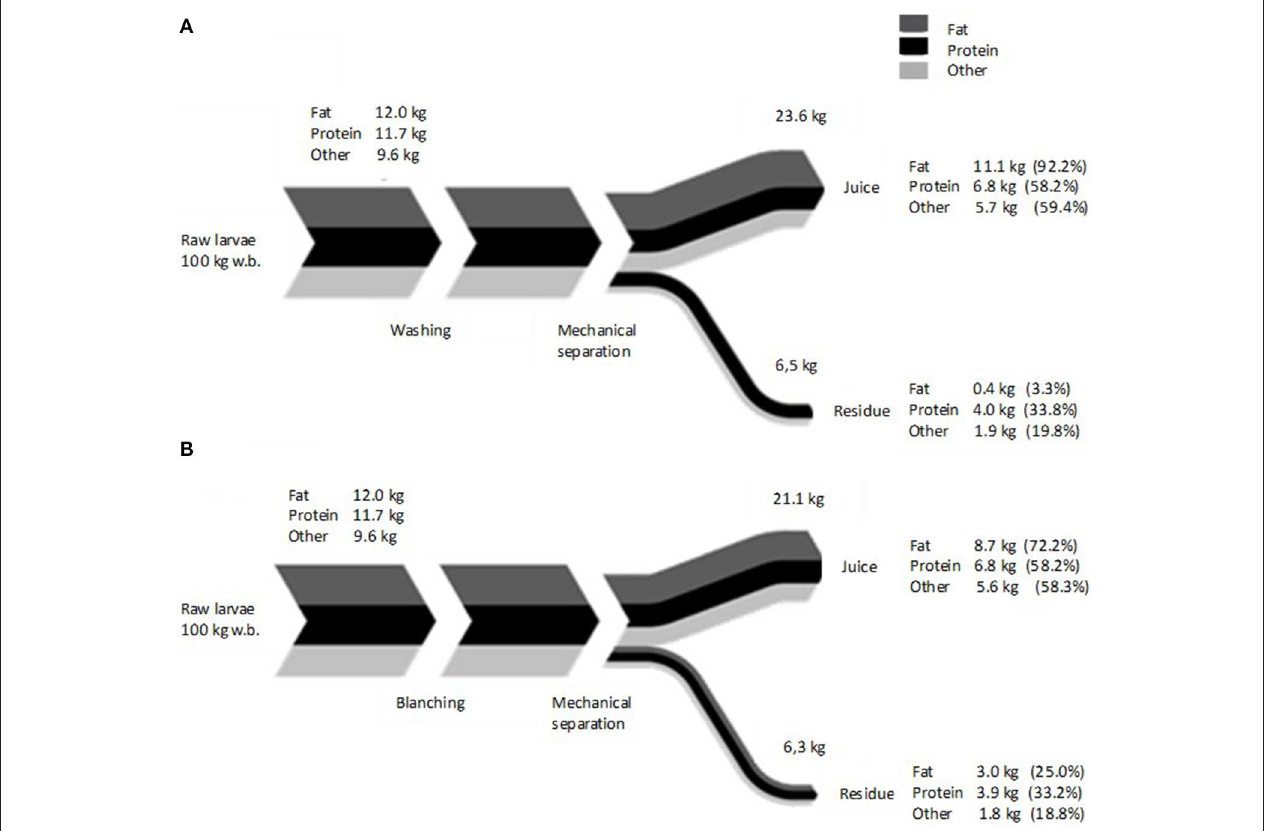
FIGURE 3 | Average mass balance of (A) washed, and (B) blanched larvae submitted to mechanical separation. Data are based on 100kg larval fresh basis, n = 3. Values in brackets represent the percentage of recovered component relative to the initial quantity in fresh insects. Line thickness represents the value of the fractions relative to each